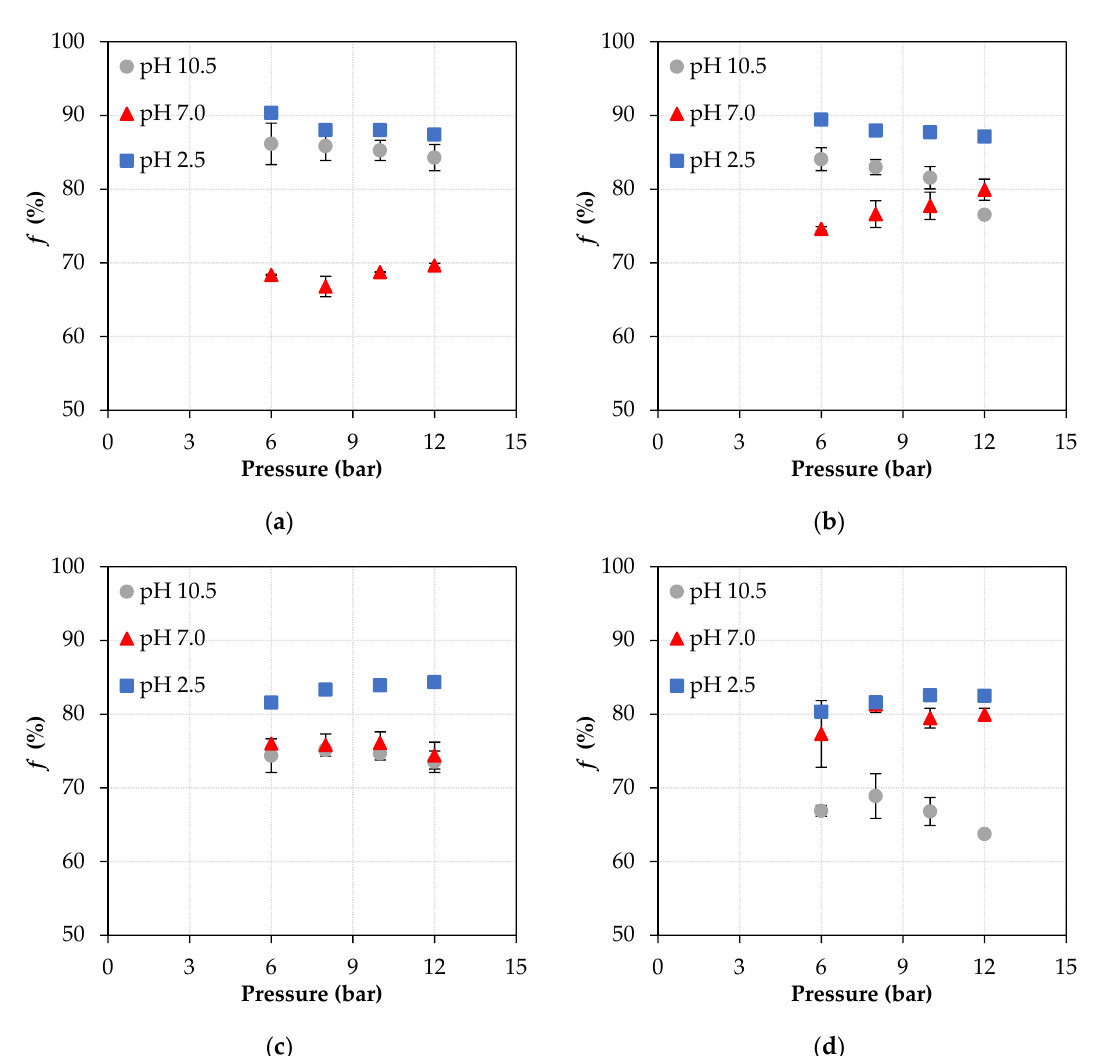
Figure 4. Apparent rejection coefficient of ATN as a function of pressure, at three pH conditions, with NF90 (top) and NF270 (bottom) membranes: ( a ), ( c ) feed solution with 8 mg L − 1 ATN; ( b ), ( d ) feed solution with 16 mg L − 1 ATN.